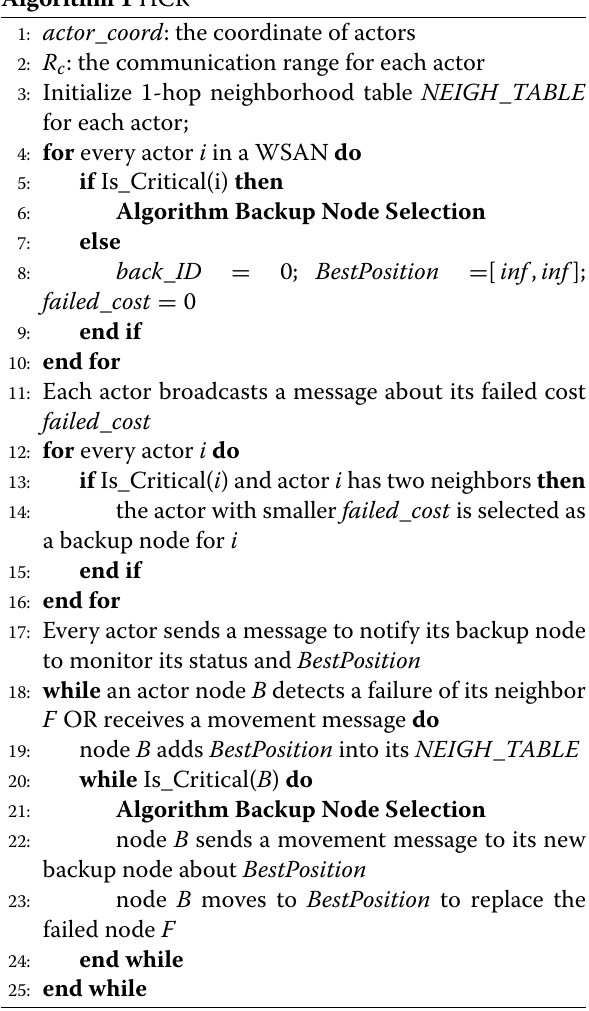
Algorithm 1 HCR